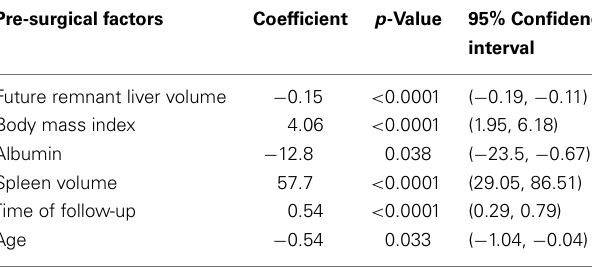
Table 4 | Multiple regression analysis performed to compare the regeneration parenchymal rate to the future remnant liver volume: the stepwise regression coefficient represents the contribution to the response comparison after it has been adjusted for other predictor